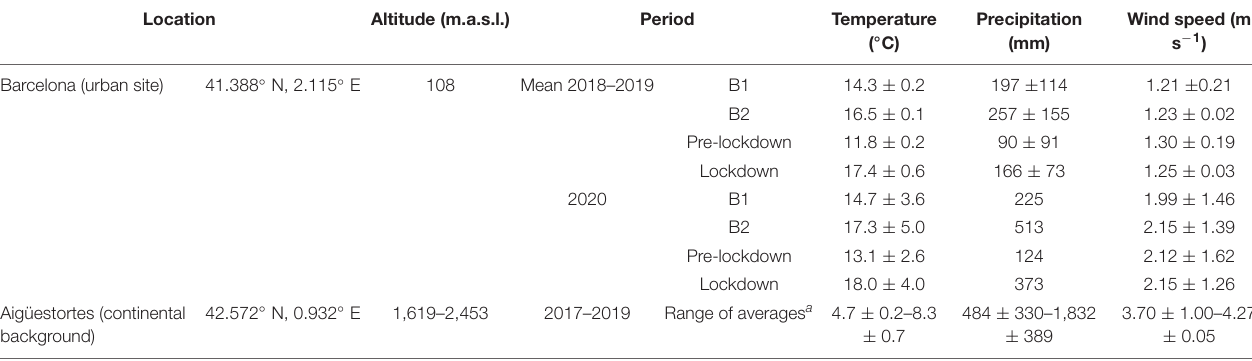
TABLE 1 | Sampling locations, periods of study, and average meteorological conditions ( ± standard